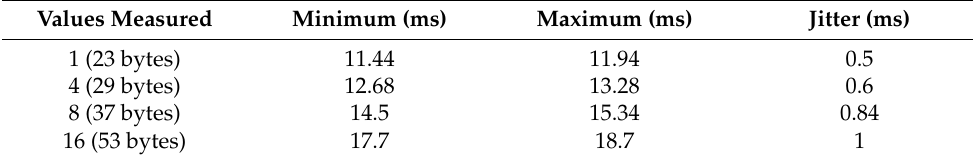
Table 5. Reception timestamps of Smart Measuring Nodes at the Coordinator Node (in ms).